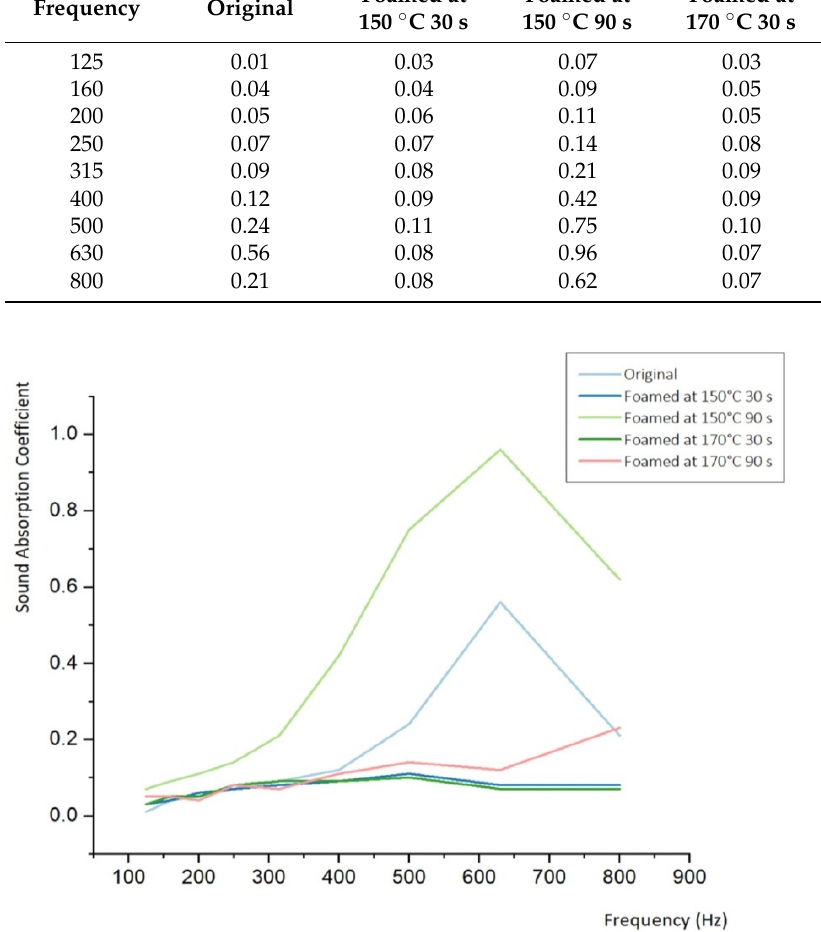
Figure 8. Sound absorption coefficient–frequency curve of microcellular foamed ceramic urethane obtained using an impedance tube (Low-frequency).